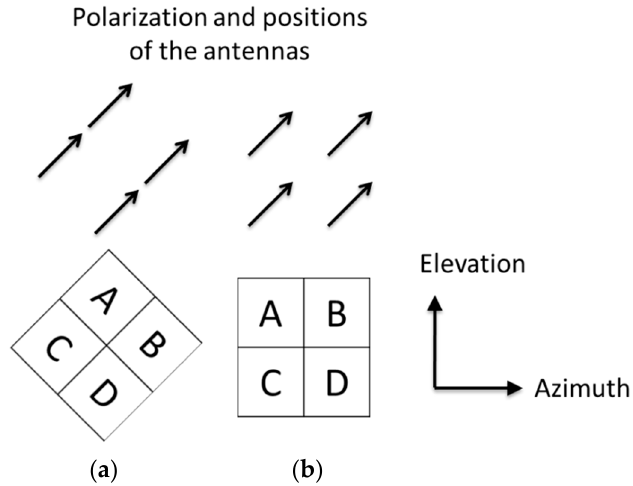
Figure 6. Monopulse antenna directions when ( a ) the total feed is rotated 45° and ( b ) the antenna elements are rotated 45°.